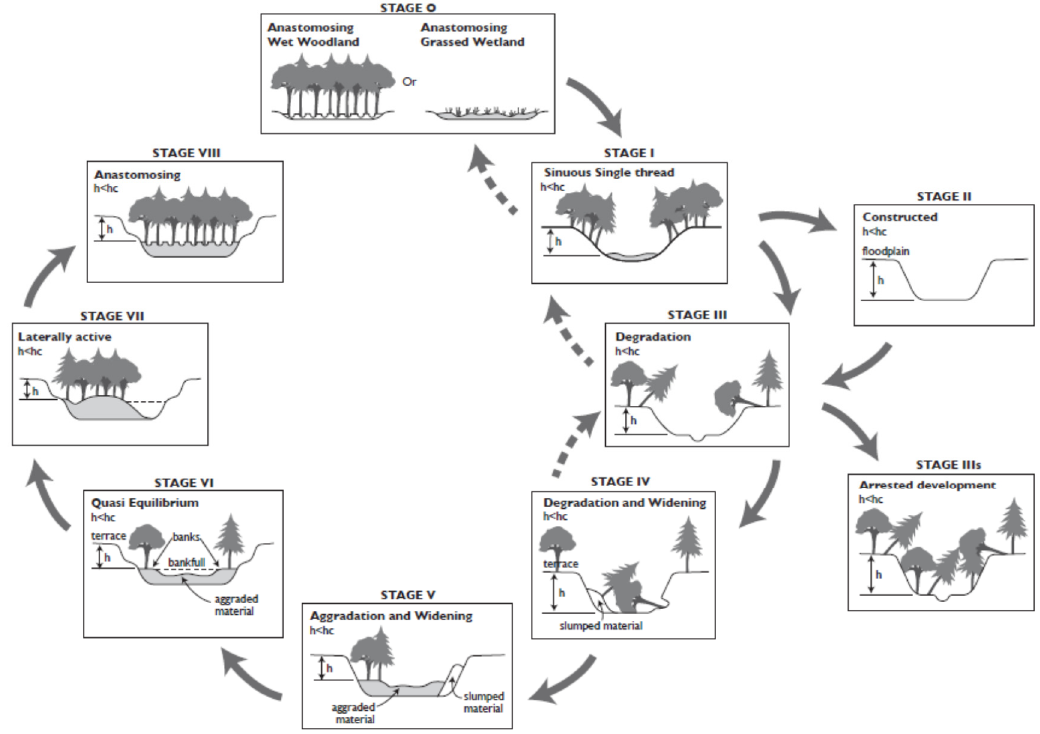
Figure 3. Stream Evolution Model from: Cluer and Thorne [24].